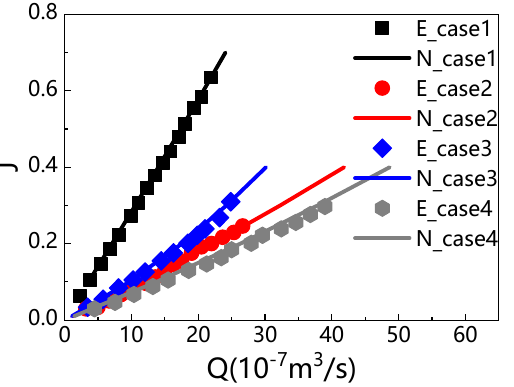
Figure 13. Comparison of experimental results with the numerical results of Model 2.